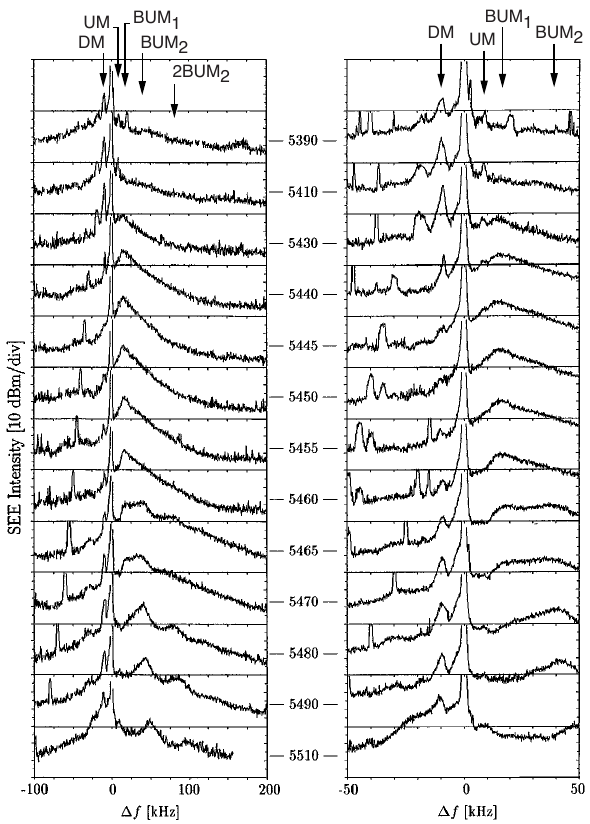
Fig. 9. The behavior of the downshifted maximum (DM), upshifted maximum (UM), the broad upshifted maxima 1 and 2 (BUM 1 and BUM 2 ) , and the second harmonic of the BUM 2 (2BUM 2 ) near the fourth gyroharmonic. These data were taken at the Sura HF facility on 3 September 1997, 13:10 to 13:50 LT, using an effective radi- ated power of 150MW. Two spectra with different frequency spans are presented for each pump frequency. Adapted from Frolov et al. (1998), Fig.